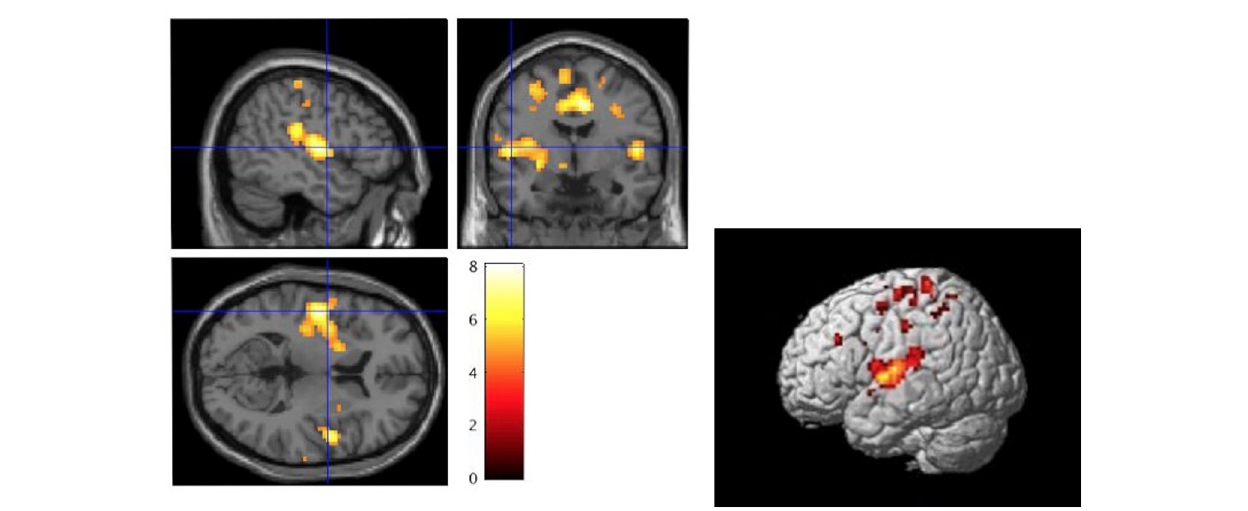
FIGURE 2 | Whole brain analysis of high functioning ultra-high risk psychosis (NHS-UHR) > control group (CG) for the contrast: neutral + happy + disgust + fear during the face emotion recognition task ( p < 0.05, FWE-corrected). The color bar represents t-values ranging from 0 to 8. The left picture displays a significant peak at 51/-1/5 (MNI Space) of a cluster ranging over the right superior temporal cortex and the left insula [Cluster labeling was executed using the automated anatomic atlas (AAL; Tzourio-Mazoyer et al., 2002)]. The left image was created with the section view provided by SPM12 and as a template the volumetric image single_subj_T1.nii based on the study by Holmes et al. (1998). The right image was created using render view ( render_single_subj.mat ) which is also provided by SPM12.